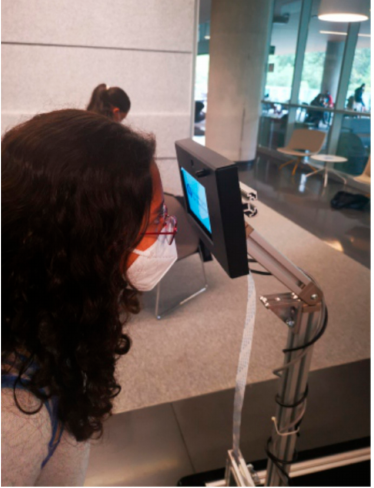
Figure 26. User interaction with the temperature sensor.